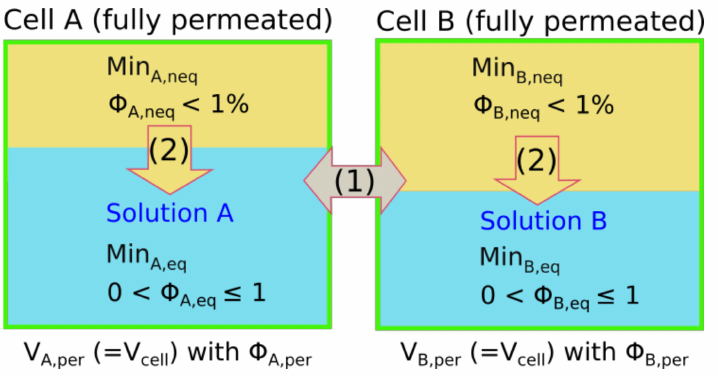
Figure 4. Fully permeated cells can still contain non-equilibrated minerals due to their lower dissolution rates. Internal dissolution (2) within a cell reduces the amount of non-equilibrated minerals; additionally, they are considered for Interchange (1). The average porosity of the permeated part Φ per corresponds to the average porosity of the cell and is used for interchange as well as for flow and transport